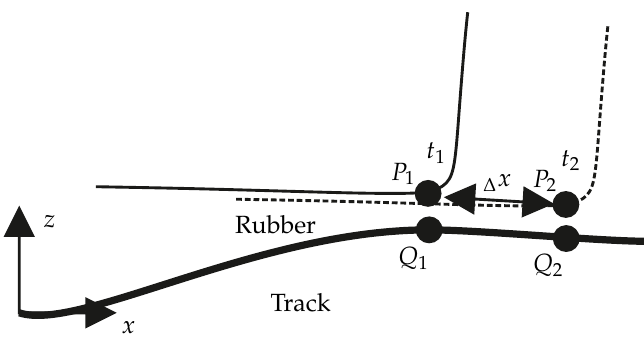
Figure 14. Schematic diagram of wiping edge